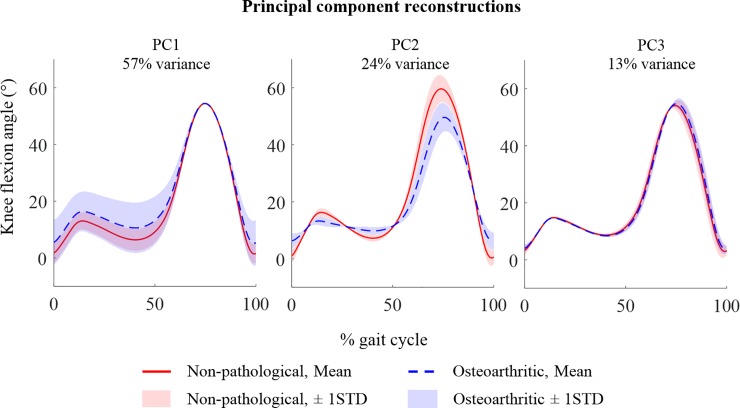
Exemplar PC reconstruction using the first three principal components (PCs) of the knee flexion waveforms during the gait cycle.The mean and ±1 STD waveforms of 30 non-pathological (NP) and 30 osteoarthritic (OA) subjects are plotted for individual reconstructions of the first three principal components (PC1-3). The exemplar waveforms and intended to demonstrate how different PCs represent different modes of variation across the waveforms. For example, PC1 reconstructs variation in magnitude of knee flexion during stance phase which isn’t discriminatory of OA gait. The reconstruction using PC2 highlights that this component represents changes in range of motion throughout the stance phase of gait, which is related to a reduced and delayed peak knee flexion during swing phase. The third PC reconstructs only 13% of variance of all the waveforms–primarily representing differences during terminal swing phase of gait.